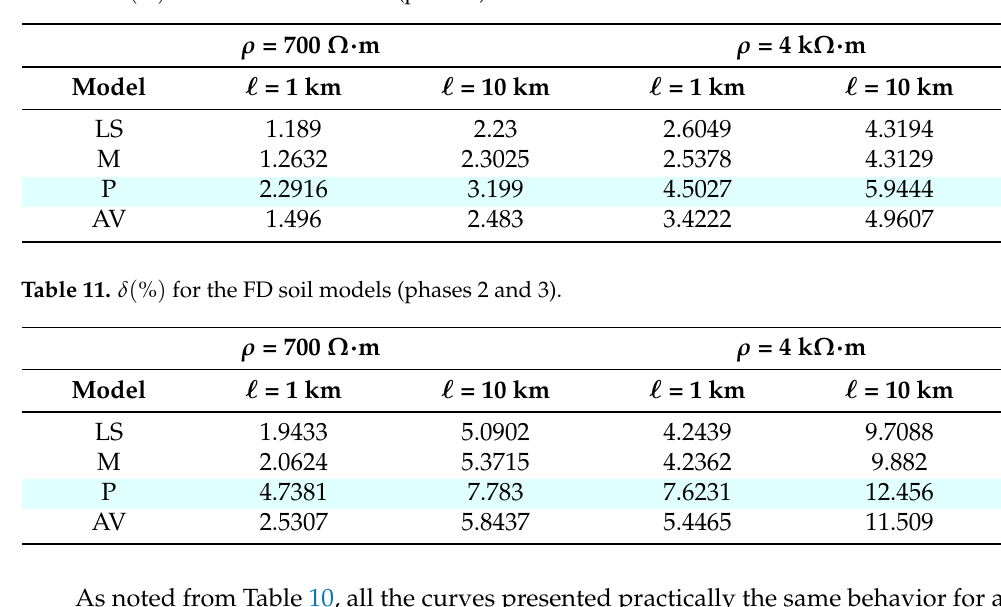
Table 10. δ ( % ) for the FD soil models (phase 1).